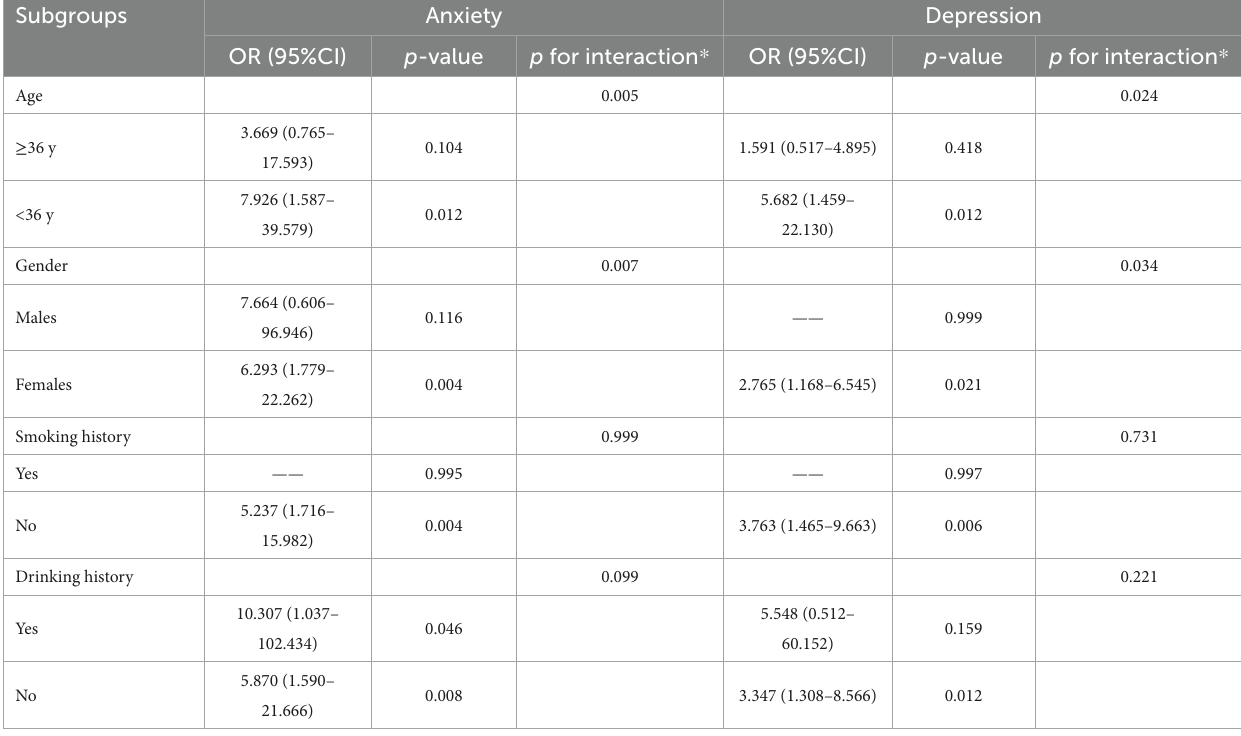
TABLE 3 Effect of anxiety and depression on migraine stratified by subgroups. Subgroups